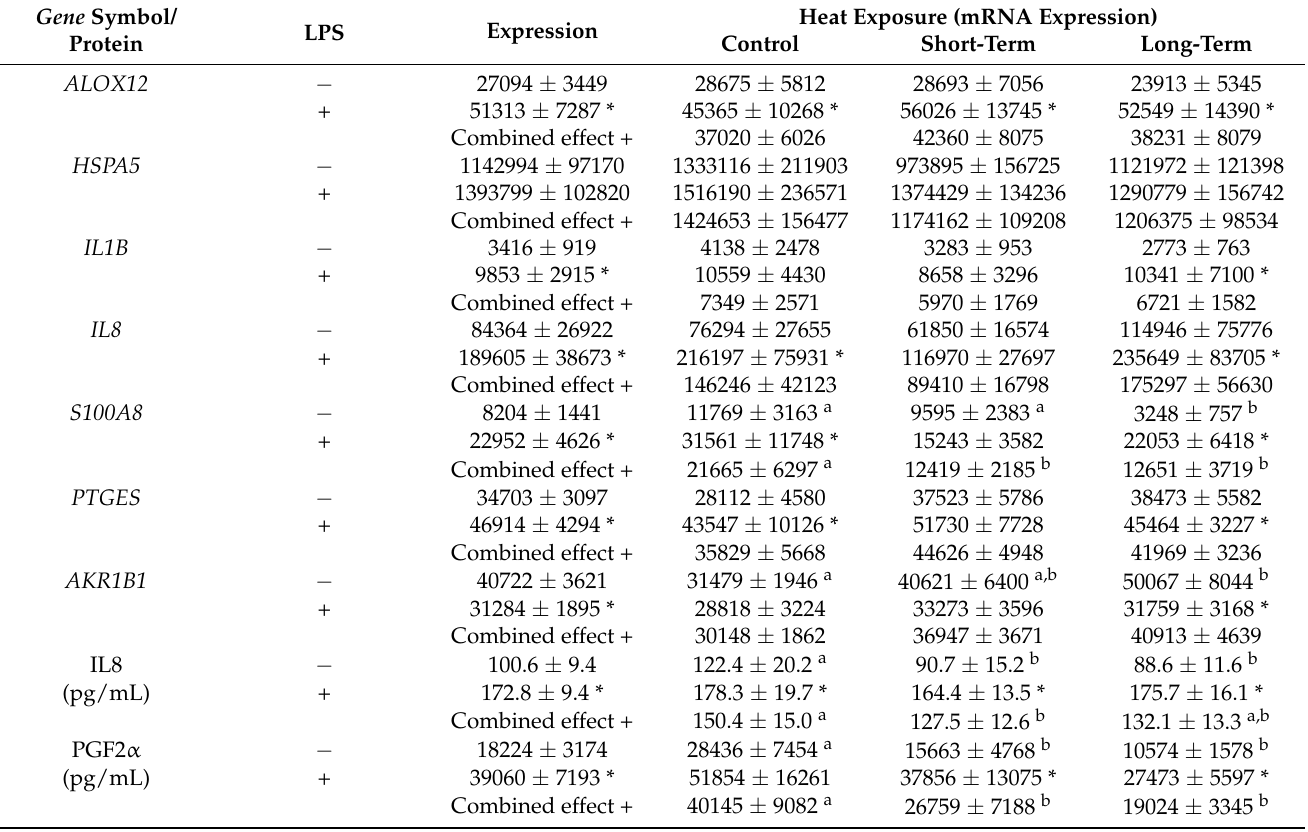
Table 2. Comparison of mRNA expression (expressed in fg/ µ g reverse-transcribed RNA) and concentrations of secretory IL8 and PGF2 α (pg/mL) on the bovine endometrial cells regarding the effects of heat exposure conditions in the presence of LPS (100 ng/mL for 12 h) #